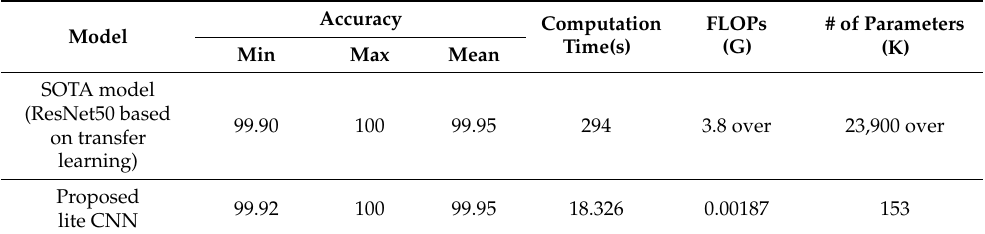
Table 7. Comparison of the bearing fault diagnosis accuracy performance and computation complex- ity measures (computation time, number of parameters, and Flops) of the proposed lite CNN model against ResNet based SOTA